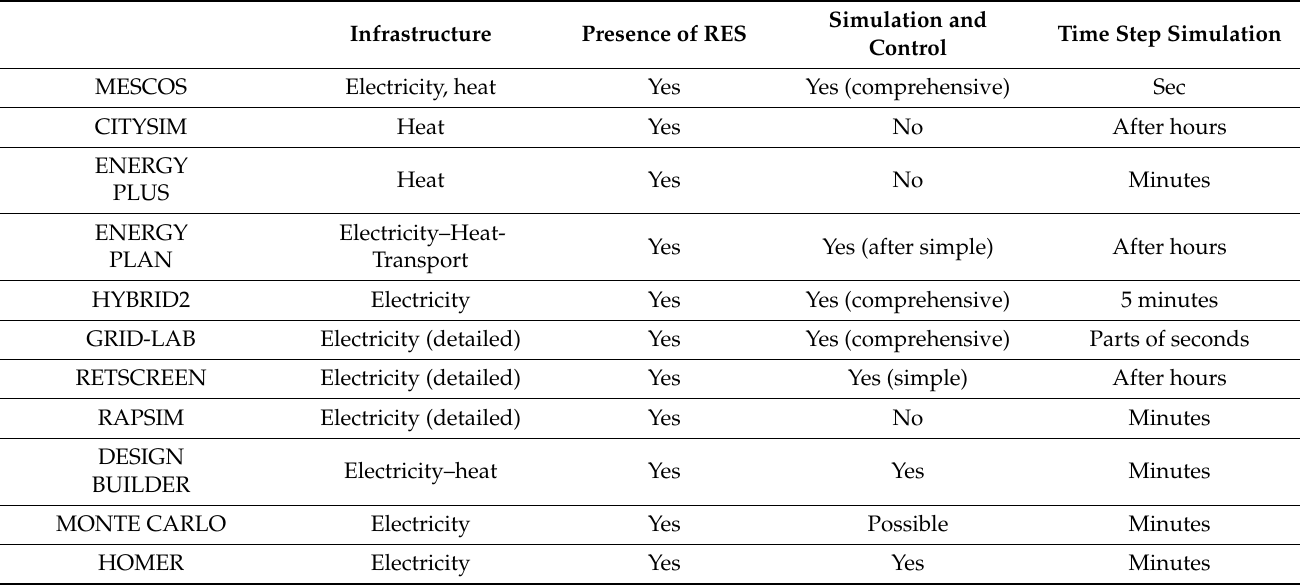
Table 4. Synthesis of model approaches for RES solutions within a building cluster [22]. Infrastructure Presence of RES